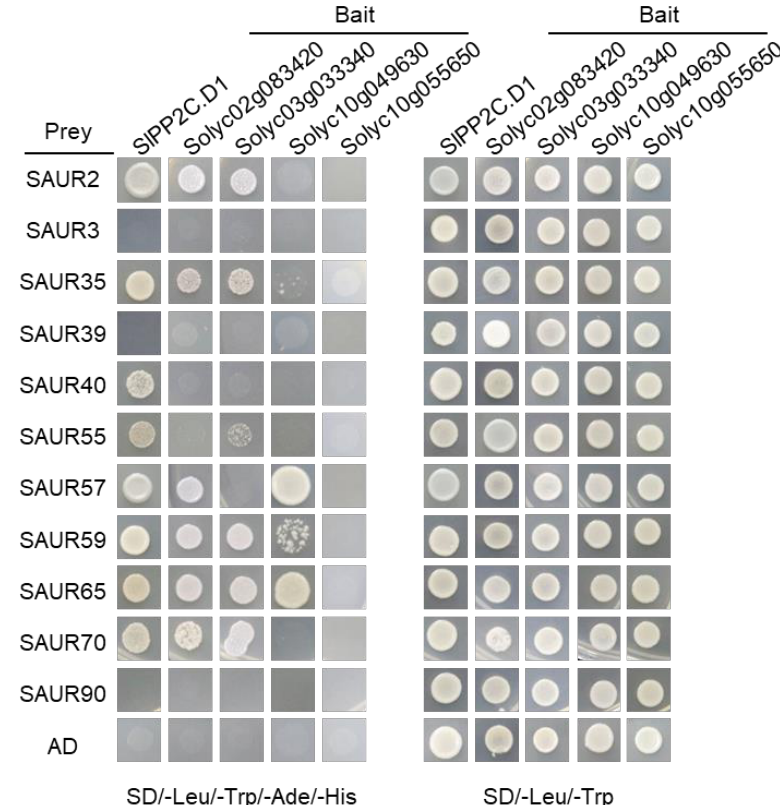
Figure 6. Interaction between SlPP2C.D with SlSAUR proteins in the Y2H assay. Tomato SlPP2C.D proteins were fused with the DNA-binding domain (BD) in pGBKT7 , and full-length SlSAUR proteins were fused with the activation domain (AD) in pGADT7 , respectively. Transformed yeast was grown on synthetic dropout lacking Leu and Trp (SD/ − 2) as transformation control or selective medium lacking Ade, His, Leu, and Trp (SD/ − 4) to test protein interactions. The empty pGADT7 vector was co-transformed with SlPP2C.D proteins in parallel as negative controls.